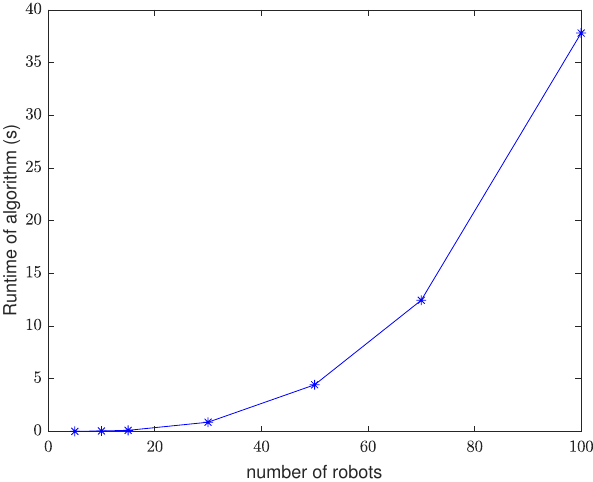
Figure 5. Relationship between the runtime of algorithm and the number of